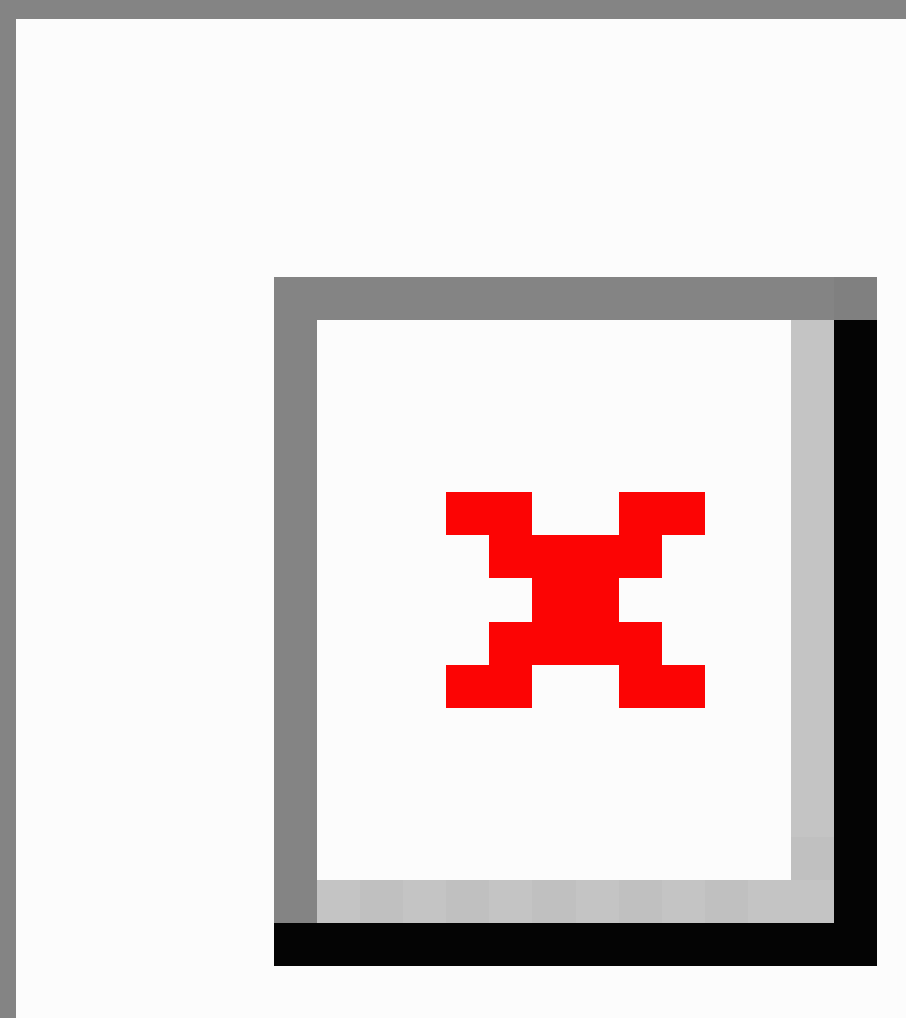
Figure 1. Flow chart of eligible threads and reasons for